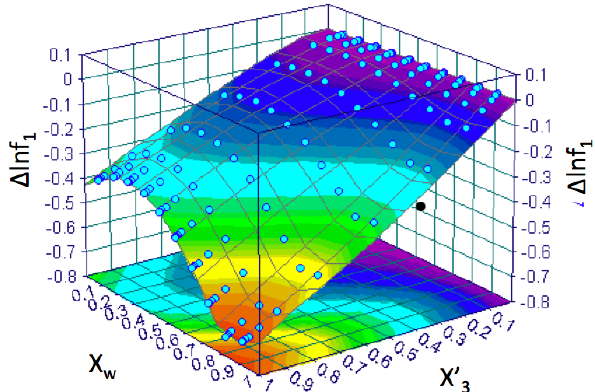
Fig. 2. Difference in activity coefficient of compound 1 as a function of x 0 and x w . The compound numbers and SMILES strings are listed in Table 1. The colour-scale is bound by red (low values) to purple (high values).